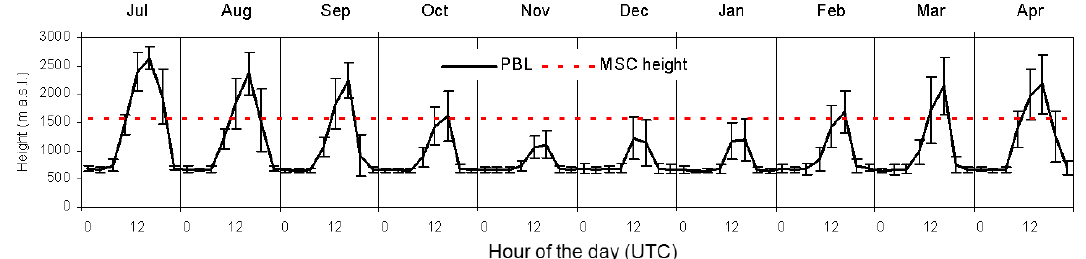
Figure 1. Diurnal variation of the boundary layer height (computed with HYSPLIT model) averaged for each month during the study period at Montsec. Variation bars indicate ± standard